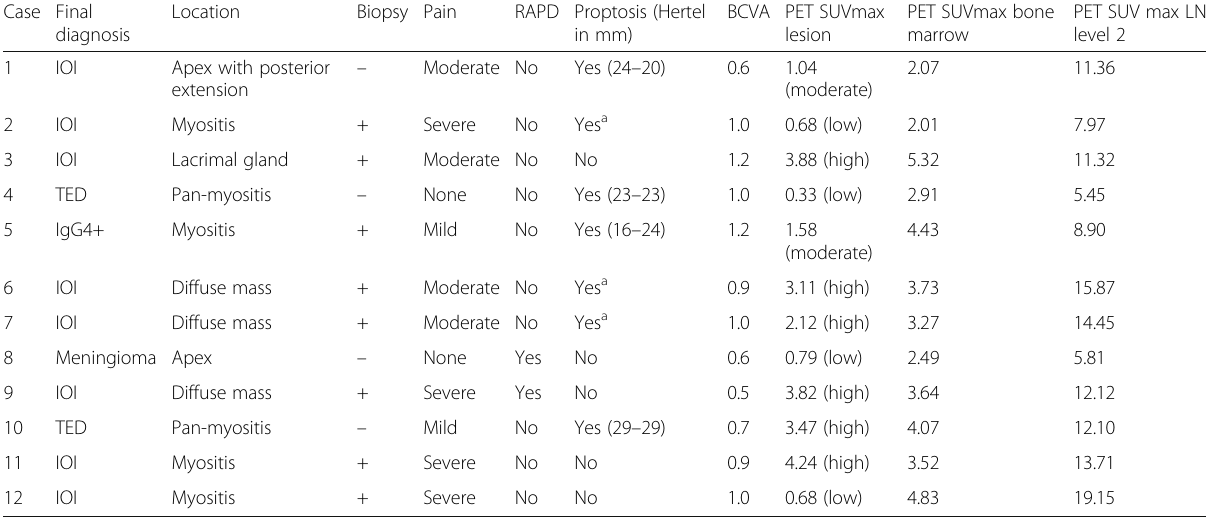
Table 1 Representation of the cases for diagnosis and PET/CT intensity values Case Final